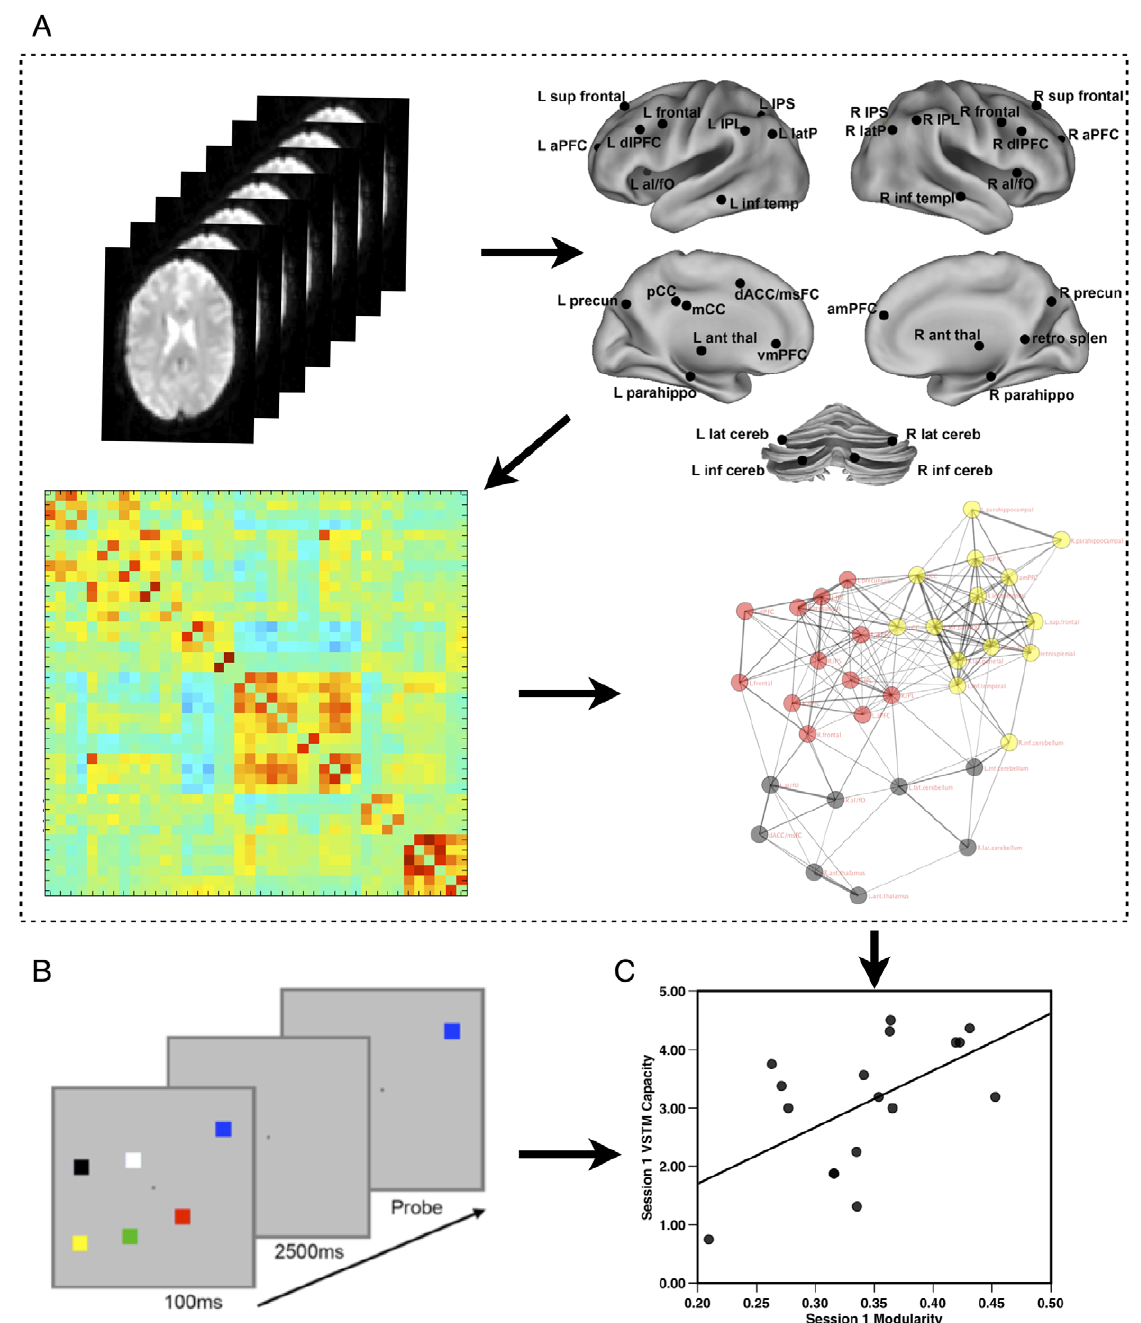
Figure 1. Study design for a single session. The visual short-term memory task was administered prior to the resting state scans in Session 1 and three weeks later at Session 2. a ) Functional MRI was conducted while subject maintained relaxed fixation on a crosshair. Low-frequency time course data was extracted from 34 brain regions (nodes) for each subject and a correlation matrix of all 34 nodes was constructed and binarized at a threshold of r=0.25 for each participant. The community structure (modularity) of each participant’s network was determined using a modularity maximization technique [30], and is here visualized using a spring-embedded graph, with node colors indicating module membership (see Supplement for details). b ) Example of the six-object VSTM task used to estimate working memory capacity. The individual participant’s capacity estimate and network modularity measures were used to compute c ) the correlation at each session and changes between sessions.